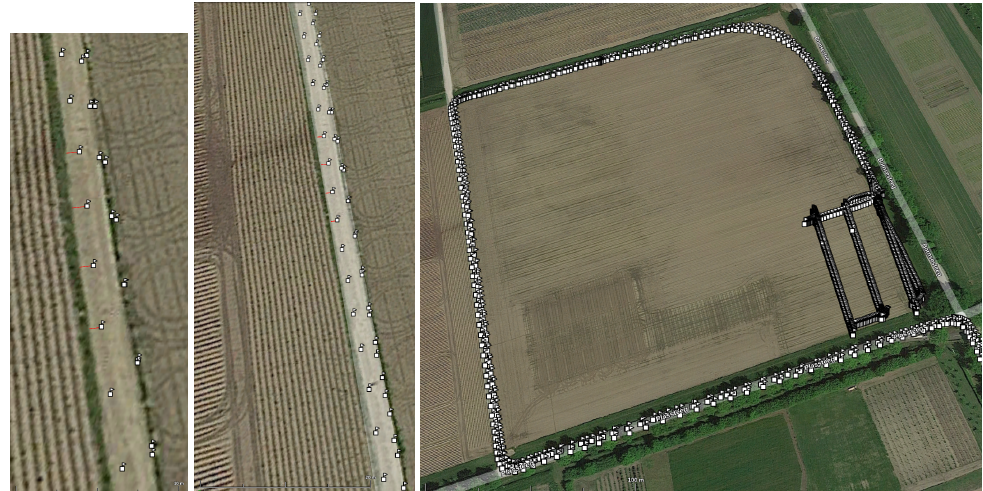
Figure 12. Detail of TPSD WARTK trajectory, showing (with a zoom from the right to the left ) the consistency of the tractor distance to the path border (representative red segments at the left-hand plot with lengths of 97 cm, 96 cm, 91 cm and 83 cm) with the expected WARTK accuracy at decimeter